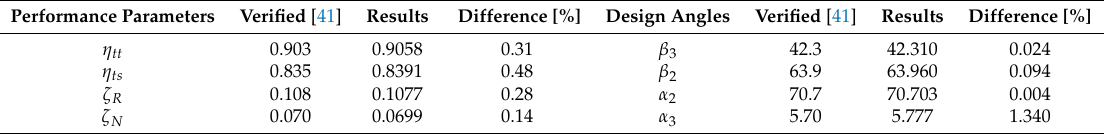
Table 2. 100 kW supercritical carbon dioxide (sCO 2 ) turbine design model validation.